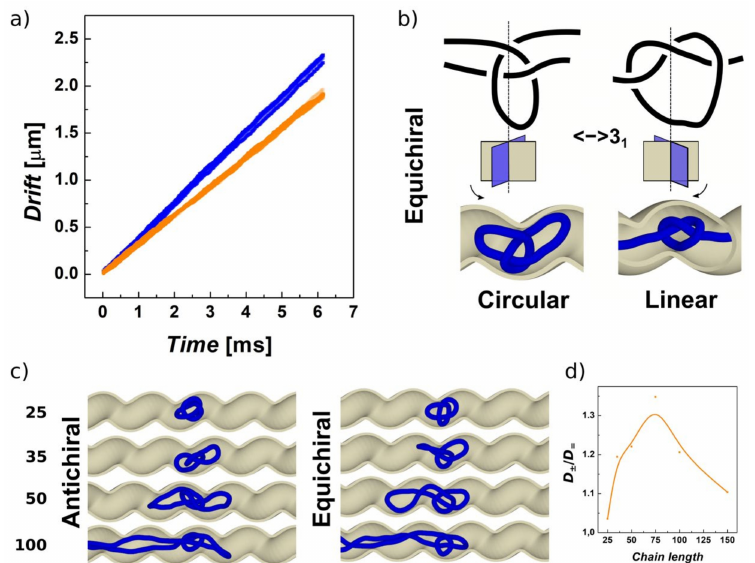
Figure 6. Stereoselectivity of helical channel ( R H = 1 σ ) on trefoil embedded on a circular chain. ( a ) Total drift over the time for antichiral and equichiral system shown for 5 overlapped trajectories for each setting. ( b ) Difference between orientation of the plane of the righthanded knot’s arc that is responsible for friction with the walls of the helical channel and stereoselective effect. ( c ) Snapshots from the molecular dynamics simulations showing circular chains with different handedness and also different lengths of the polymer indicated by number. ( d ) Relative difference between drift speeds in antichiral versus equichiral systems D ± / D =